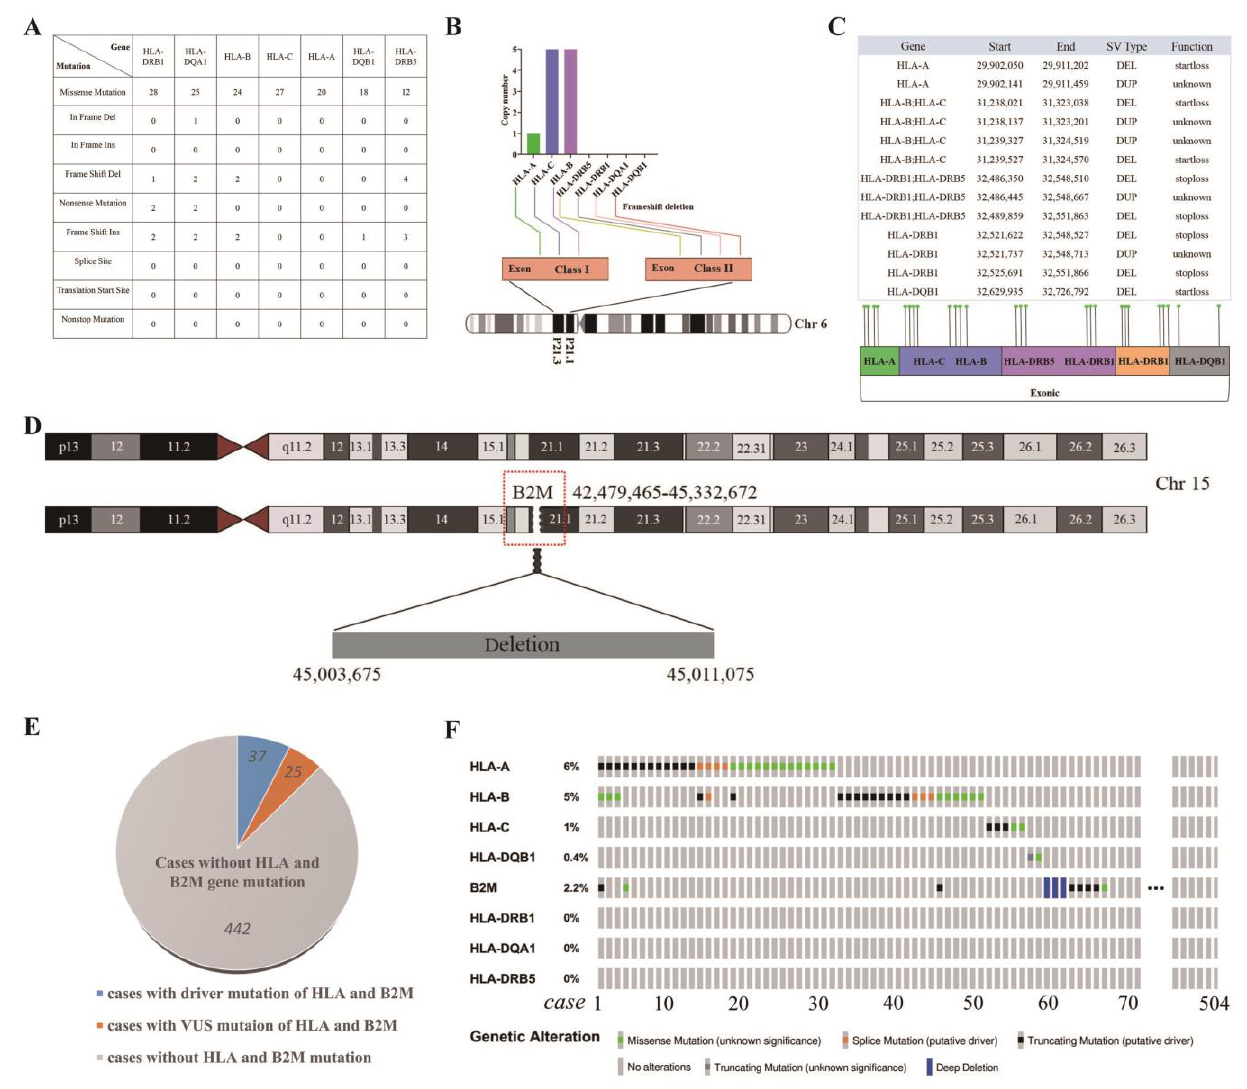
Figure 5. Mutations of MHC class I/II genes in WU-TSC-1: ( A ) SNP/Indel of mutated HLA genes. ( B ) CNV of mutated HLA genes. ( C ) SV of mutated HLA genes. ( D ) Heterozygous loss of B2M . Red box indicates the location that B2M gene LOH occurred. ( E , F ) Mutation of HLA and B2M genes in 504 HNSCC patients recorded in TCGA database.